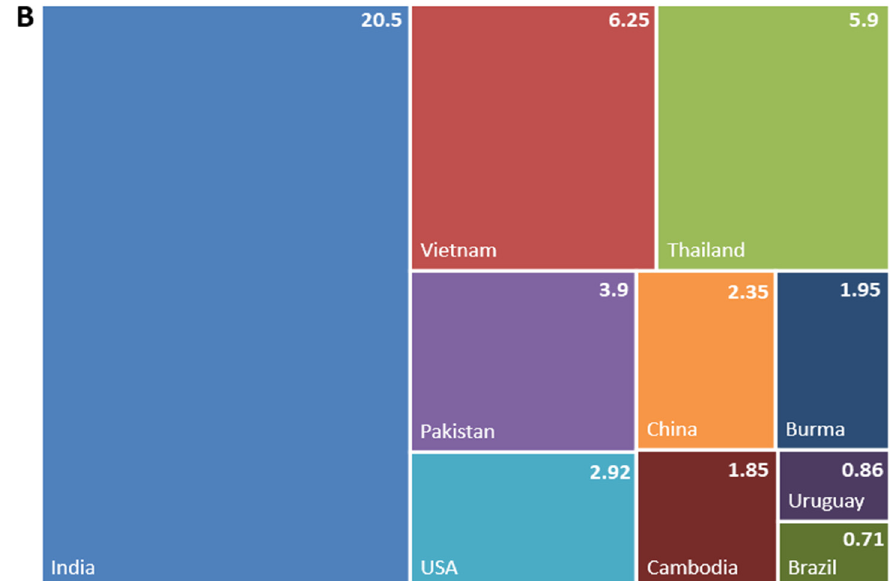
Figure 1. Identification of the 10 larger consuming, producing and exporting countries of the world ( A ) Production of milled rice in 2019/2020, and rice consumption in 2020/2021 in each of the 10 top producing/consuming countries. ( B ) The 10 main rice exporting countries worldwide with values of exportation in million metric tons. (Graphs were built based on data in [2]).